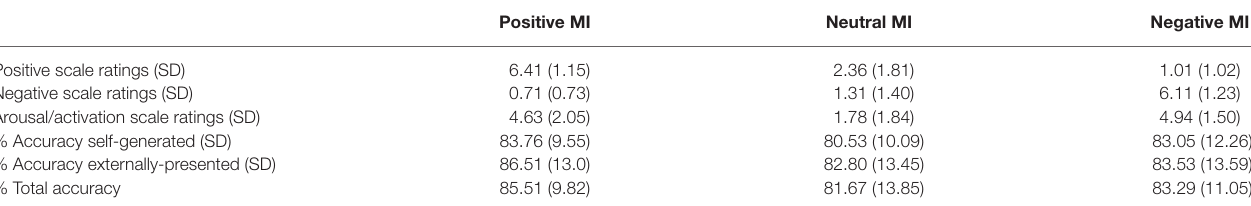
TABLE 1 | Mood induction (MI) ratings and reality-monitoring source-memory accuracy.